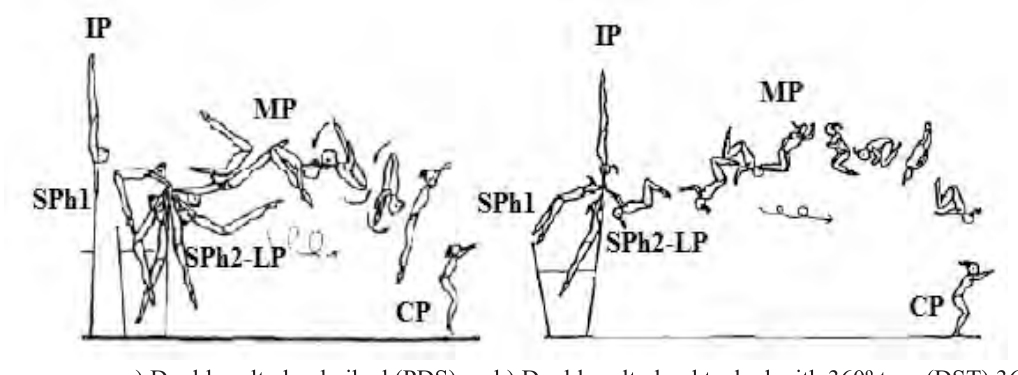
Fig. 1. Key elements of sports technique used in double salto backward dismount off uneven